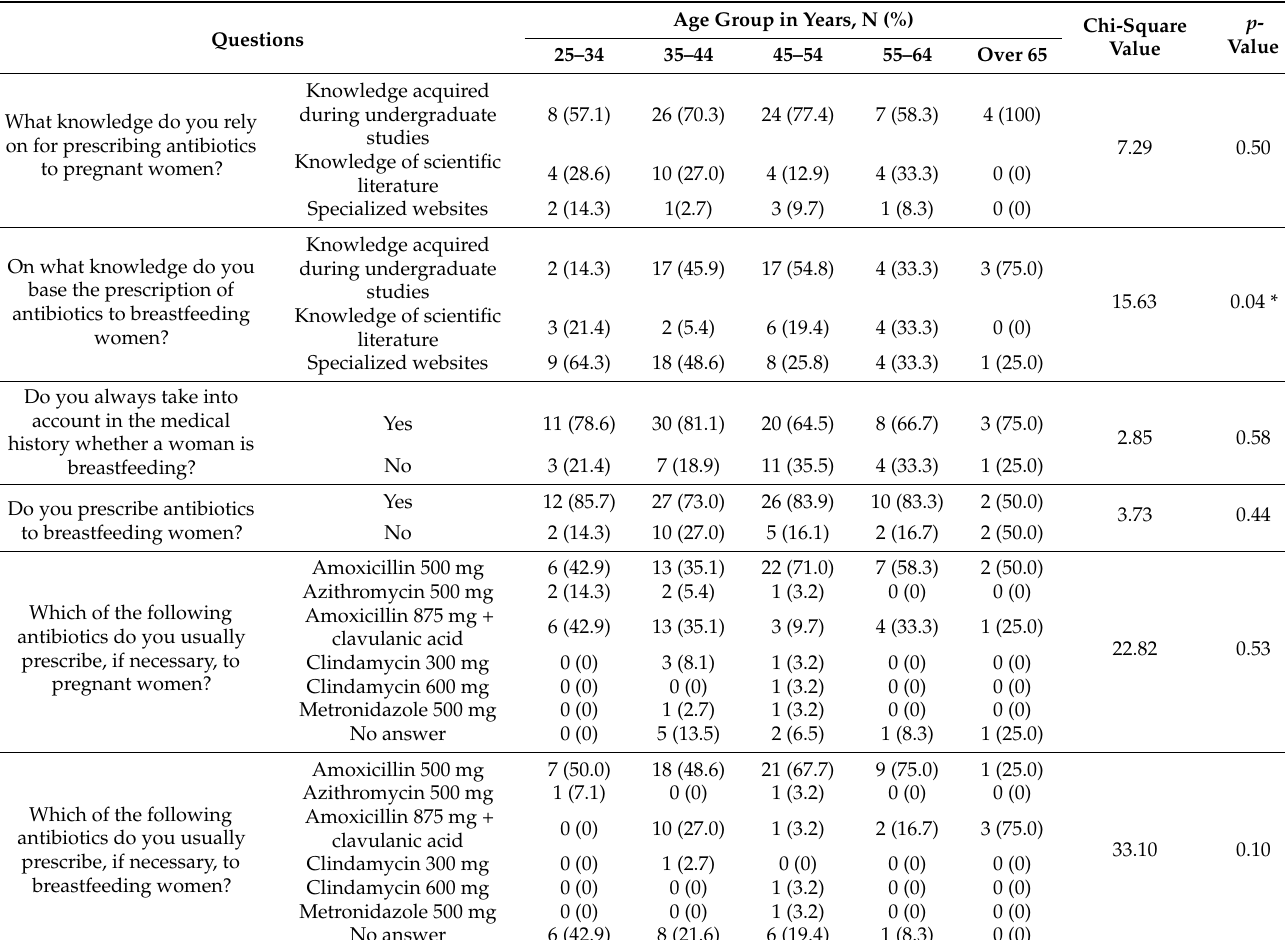
Table 2. Chi-squared test for associations among different age groups and knowledge, attitude, and practice